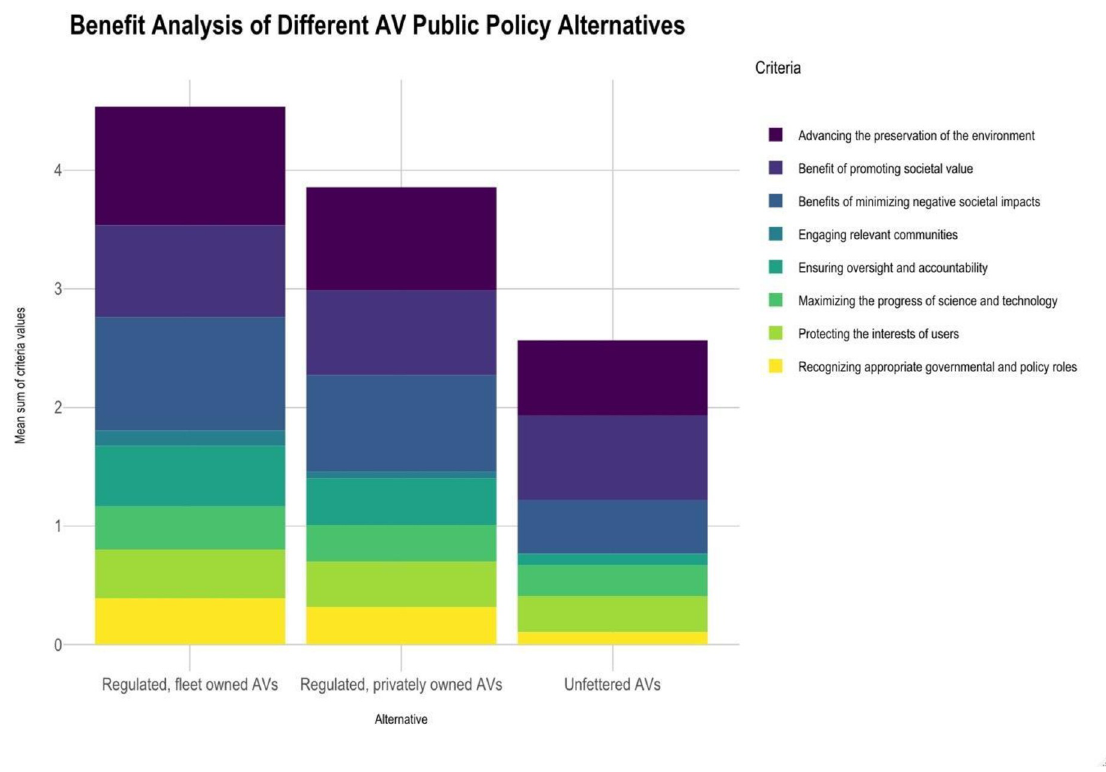
Fig 6. Mean values and standard deviations for 10-point assessments (0–9) by harm and scenario.